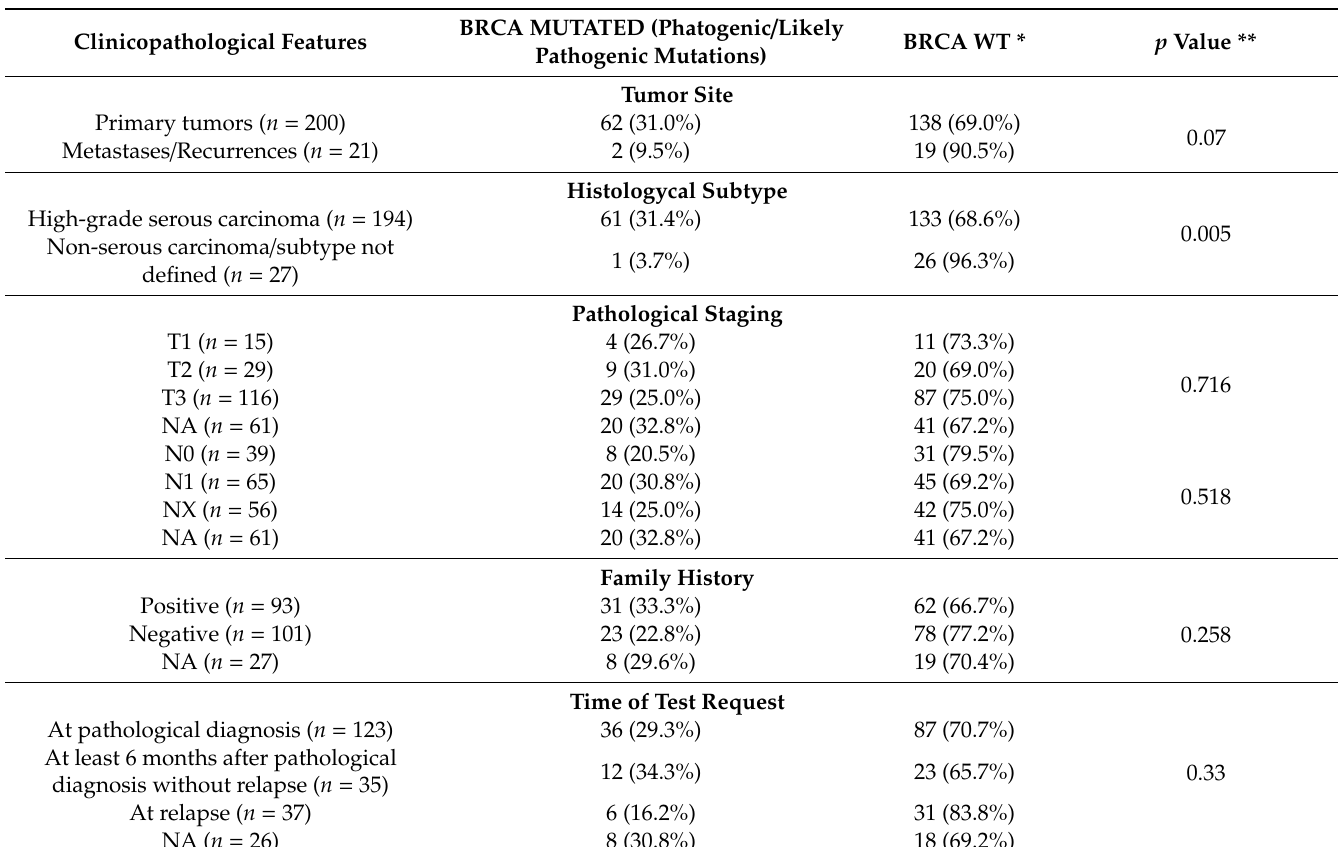
Table 2. Correlation between BRCA status and clinicopathological